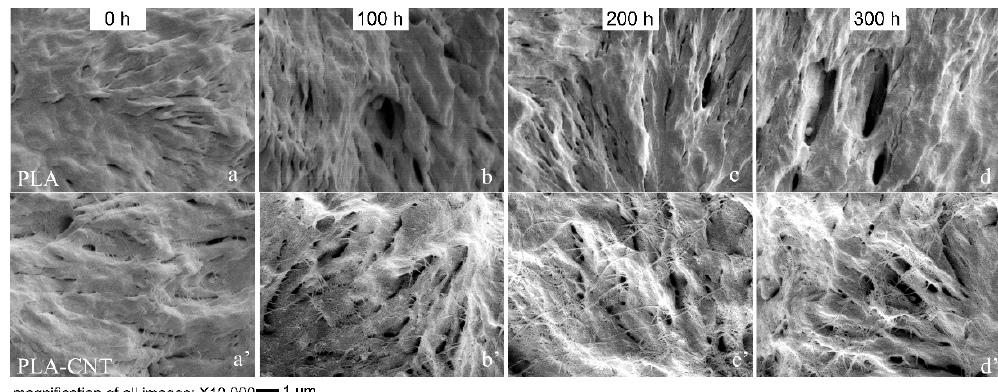
Figure 8. SEM images at 10,000× magnification illustrating the changes in the surface morphology in terms of voids and holes during 300 h of degradation; ( a – d ) PLA spherulic lamellae; ( a ’– d ’) PLA-CNT spherulic lamellae.